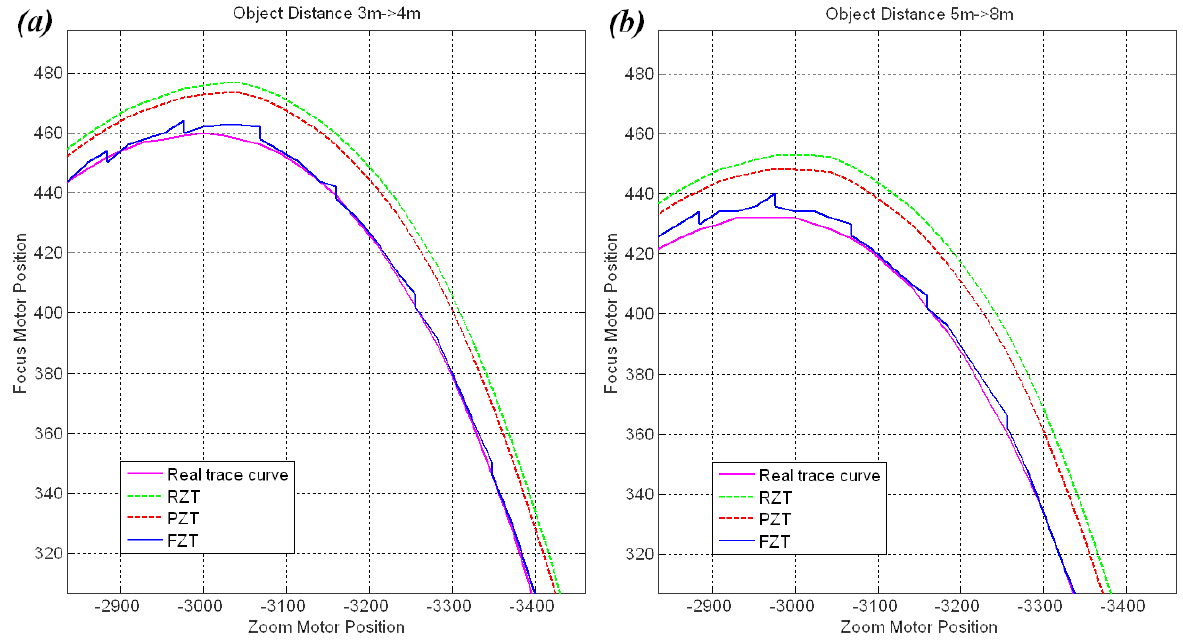
Figure 17. ( a ) Trace curves for an object moving from 3 m to 4 m; ( b ) Trace curves for an object moving from 5 m to 8 m.